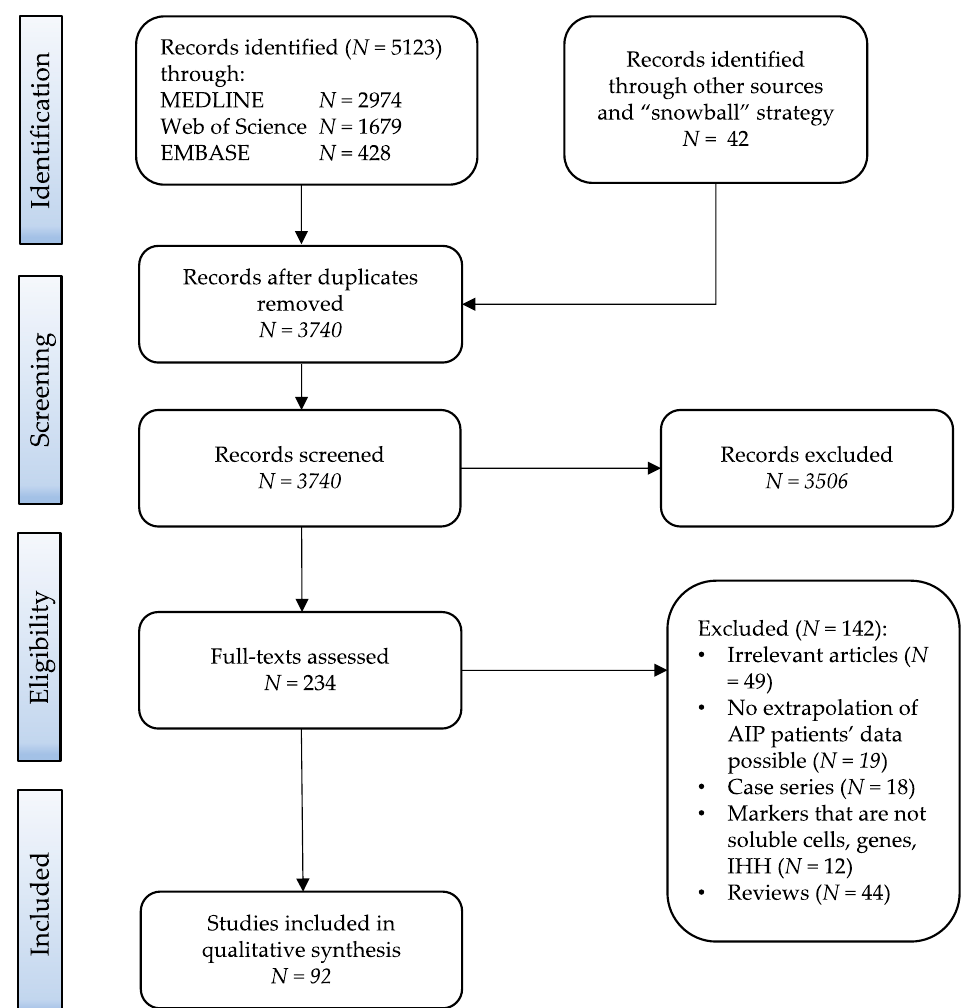
Figure 1. PRISMA flow diagram of the study selection process. After the search of databases, 3740 publications were screened, and 92 studies met the inclusion criteria. AIP—autoimmune pancreatitis; IHH—immunohistochemistry.